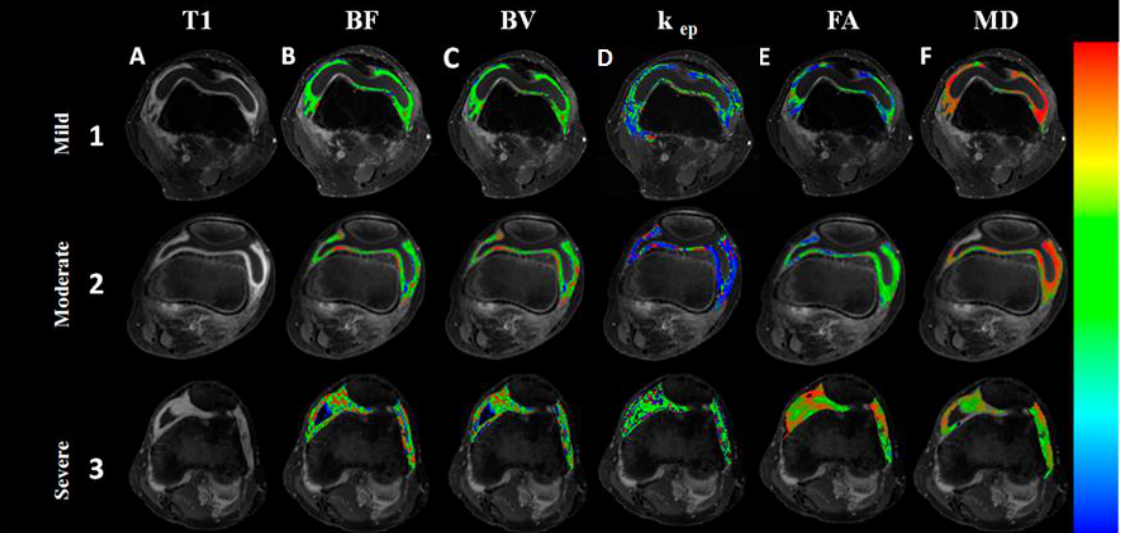
Figure 1. Imaging of the knee joints of arthritis patients presenting with varying grades of inflammation. Fat-suppressed post-contrast T1-weighted images show increase in contrast enhancement on moving from mild to severe inflammation (lane A , 1–3). On post-processing of dynamic contrast-enhanced and diffusion tensor-magnetic resonance imaging data, blood flow (BF), ( B ), blood volume (BV), ( C ), rate transfer coefficient kep (min-1) ( D ) and fractional anisotropy (FA) ( E ) maps show increase, while mean diffusivity (MD) ( F ) map shows decrease in its values on moving from mild to severe synovitis (1 – 3).